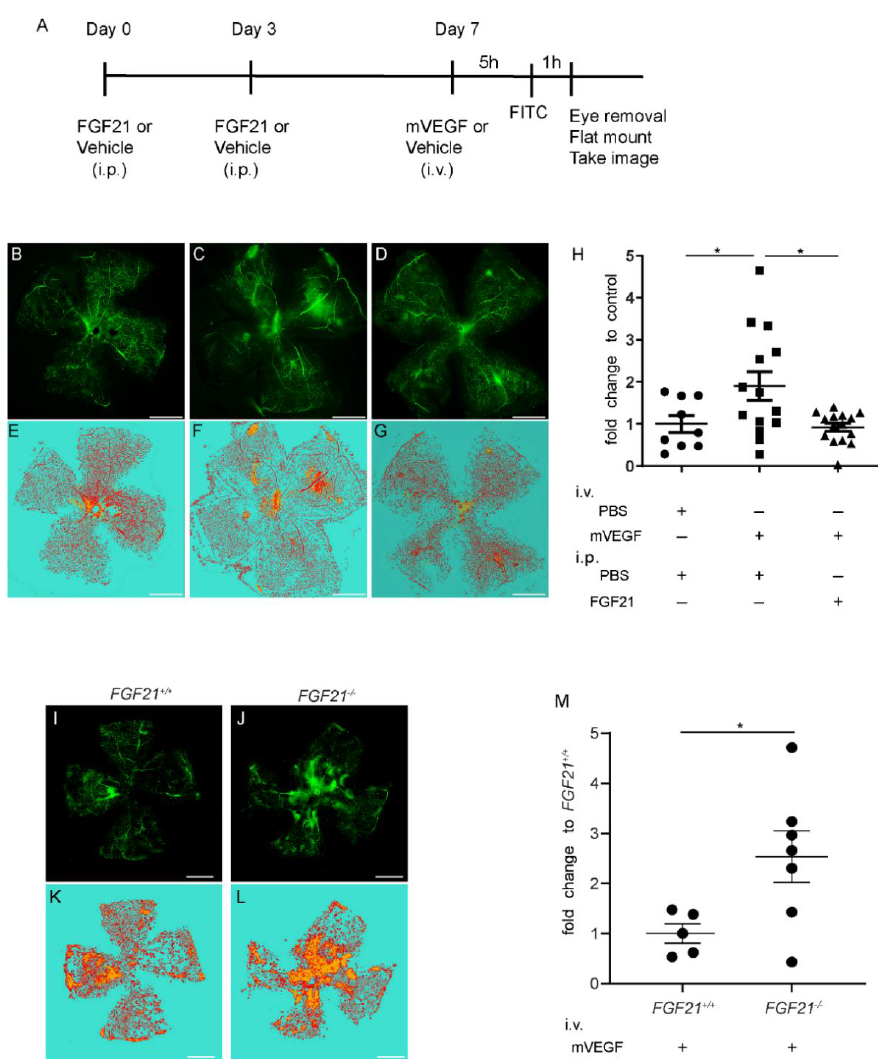
Figure 2. Fibroblast growth factor 21 ( FGF21) treatment prevents and FGF21 deficiency Increases vascular endothelial growth factor (VEGF) -induced retinal vascular leakage in the mouse model. ( A ) The time course of this study. ( B – D ) Representative confocal microscopy images of whole-mounted retina. ( E – G ) Images of retina after segmentation with ZEISS Efficient Navigation (ZEN) Intellesis. ( B and E ) Representative retinal image of controls. ( C and F ) Control Phosphate Buffered Saline (PBS) treatment with intravitreal injection of mouse (m) VEGF. ( D and G ) FGF21 (long-acting FGF21; PF05231023) treatment with intravitreal injection of mouse (m) VEGF. The yellow FITC indicates leakage; the red lectin stain indicates vessels and artifacts; the cyan shows background. ( H ) The intensity of retinal vascular leakage was increased in animals injected with mVEGF and treated with PBS (square), compared to controls (circle, n = 9 – 14; p = 0.046). Leakage intensity was reduced in FGF21 (triangle) versus PBS-treated groups ( n = 14 – 15; p = 0.01). The data were analyzed by one-way ANOVA with Tukey and were expressed as mean ± standard error (SE) Scale bar is 1 mm. ( I and J ) Representative confocal microscopy images of retinas in Fgf21 +/+ and Fgf21 -/- littermate mice. Representative images are shown. ( K and L ) Images of retina after segmentation with ZEN Intellesis. ( M ) The data were analyzed by unpaired t -test and were expressed as mean ± SE. Fold change compared with the wild type group was calculated ( n = 5 – 7; p = 0.037). Scale bar is 1mm. i.p., intraperitoneal injection, i.v., intravitreal injection, FGF21, long-acting FGF21 (PF05231023). Fold change was calculated (* p < 0.05).